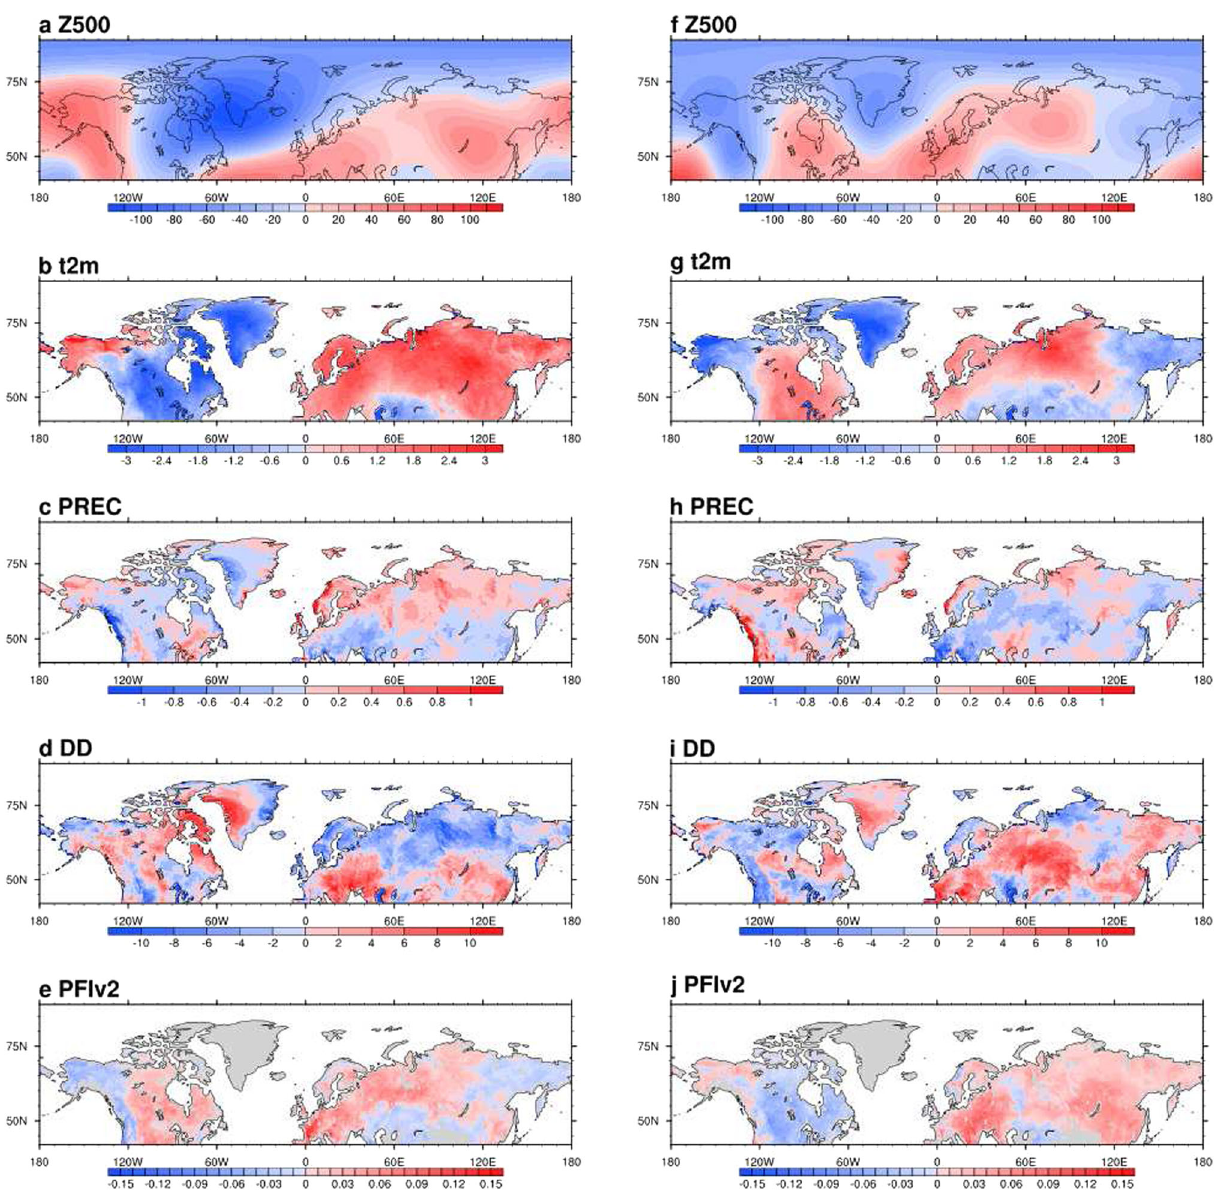
Fig. 6 Composite patterns due to AO + and PNA + . a Z500 (mb), b surface temperature (C), c 15-day running mean precipitation (mm/day), d period of drought for the 2001 – 2016 interval. e is the PFIv2. f – j is the same as a – e but for coincident AO + and PNA. Gray regions in e and f indicate sparse or absent